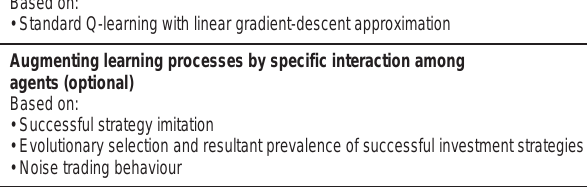
Fig. 1. Main building blocks of the ASM